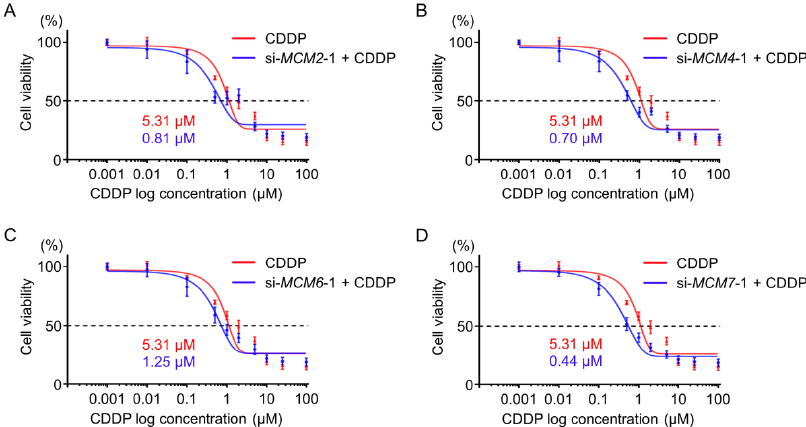
Figure 7. Effect of siRNA-mediated knockdown of MCM family members on cisplatin sensitivity. ( A – D ) The IC 50 values of cisplatin in SBC-3 cells treated with cisplatin and siRNAs targeting each MCM gene for 72 h were determined by XTT assay. The knockdown of MCM2 , MCM4 , MCM6 and MCM7 increased the toxicity of cisplatin to SBC-3